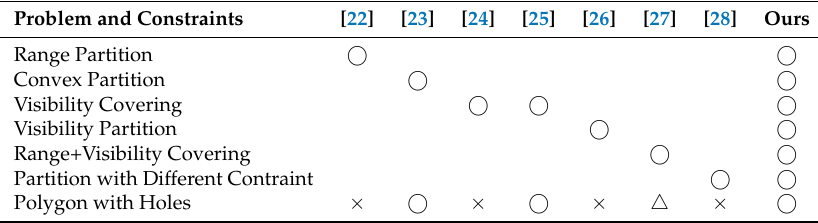
Table 1. Problems and constraints covered by previous